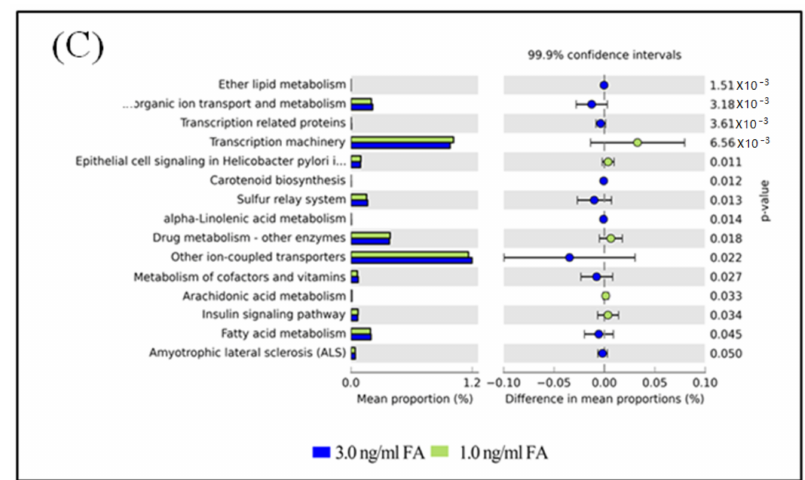
Figure 6. Differential PICRUSt predicted KEGG pathways between untreated and FA treated mice detected by STAMP software [41]. ( A ) Differential KEGG pathways between untreated and the 3.0 ng/mL FA treated mice. ( B ) Differential KEGG pathways between untreated and the 1.0 ng/mL FA treated mice. ( C ) Differential KEGG pathways between the 3.0 and the 1.0 ng/mL FA treated mice. For each comparison, the mean proportion of predicted KEGG pathways (left) and difference in mean proportions (right) were